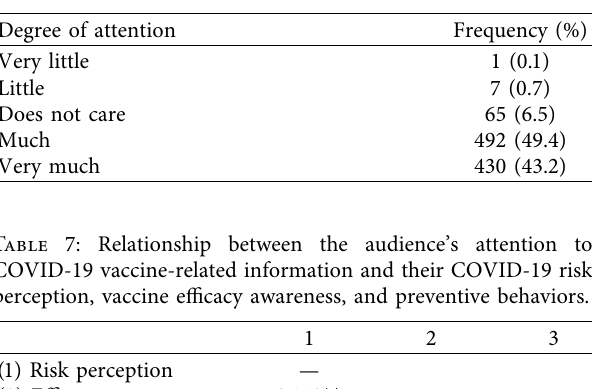
Table 6: Frequency of audience’s attention to COVID-19 vaccine-related information.